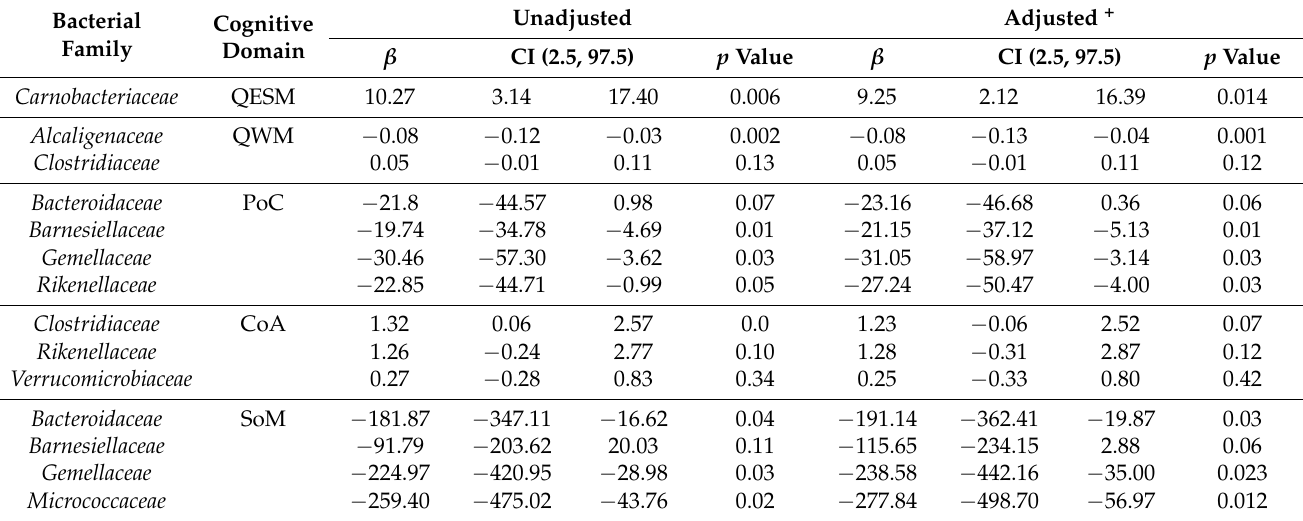
Table 4. Bacterial families in the prediction of cognition per domain, adjusted and unadjusted re- gression models.